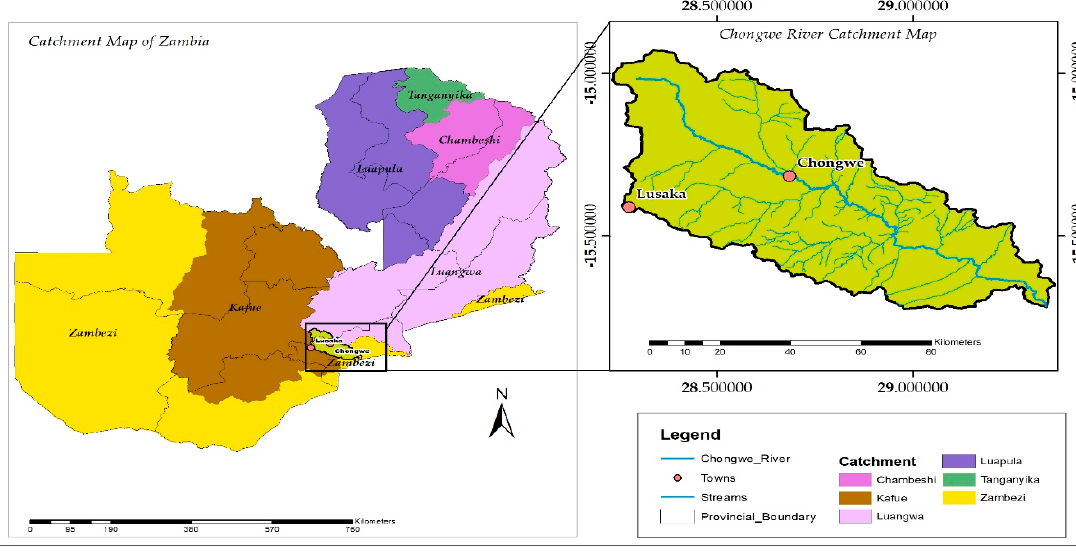
Figure 1. Location map of Chongwe River catchment .